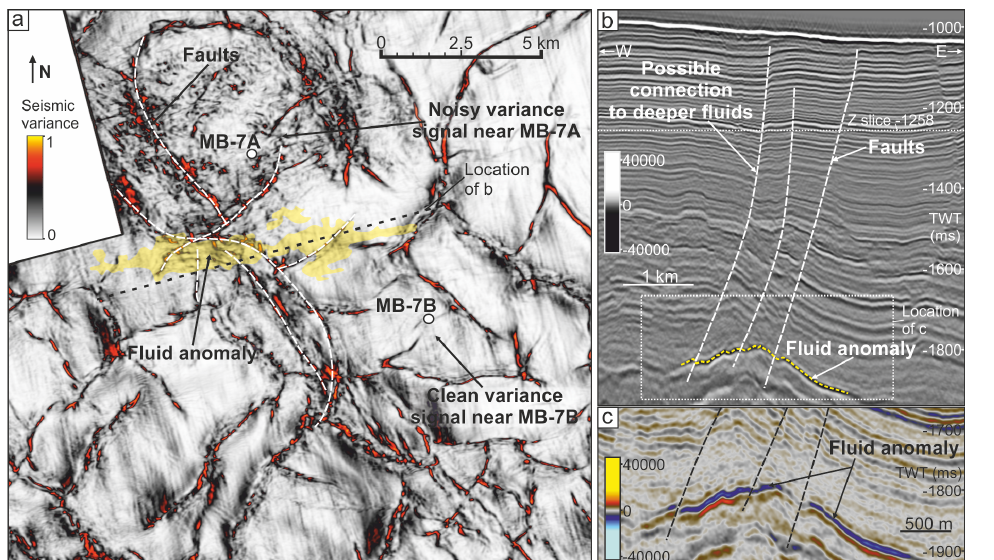
Figure 7. Fault mapping. (a) A time-slice intersection ( z slice) through the Pitu HR survey displaying the variance structural attribute to highlight fault locations at a depth of − 1258ms two-way time. Interpreted fault planes (white dashed lines) are shown as well as the spatial distribution of a potential hydrocarbon fluid anomaly that may be in pressure communication to shallower depths due to the intersection with fault planes. IODP Proposal 909 sites MB-7A (abandoned) and MB-7B (primary) are also shown as well as the location of panel (b) . The location of panel (a) is shown in Fig. 6a. (b) A seismic cross section from the Pitu HR survey in black and white to emphasize faults, which displays interpreted fault planes and the location of a deeper fluid anomaly as well as the location of panel (c) . (c) An enlarged seismic cross section from the Pitu HR survey that shows the seismic character of the deeper fluid